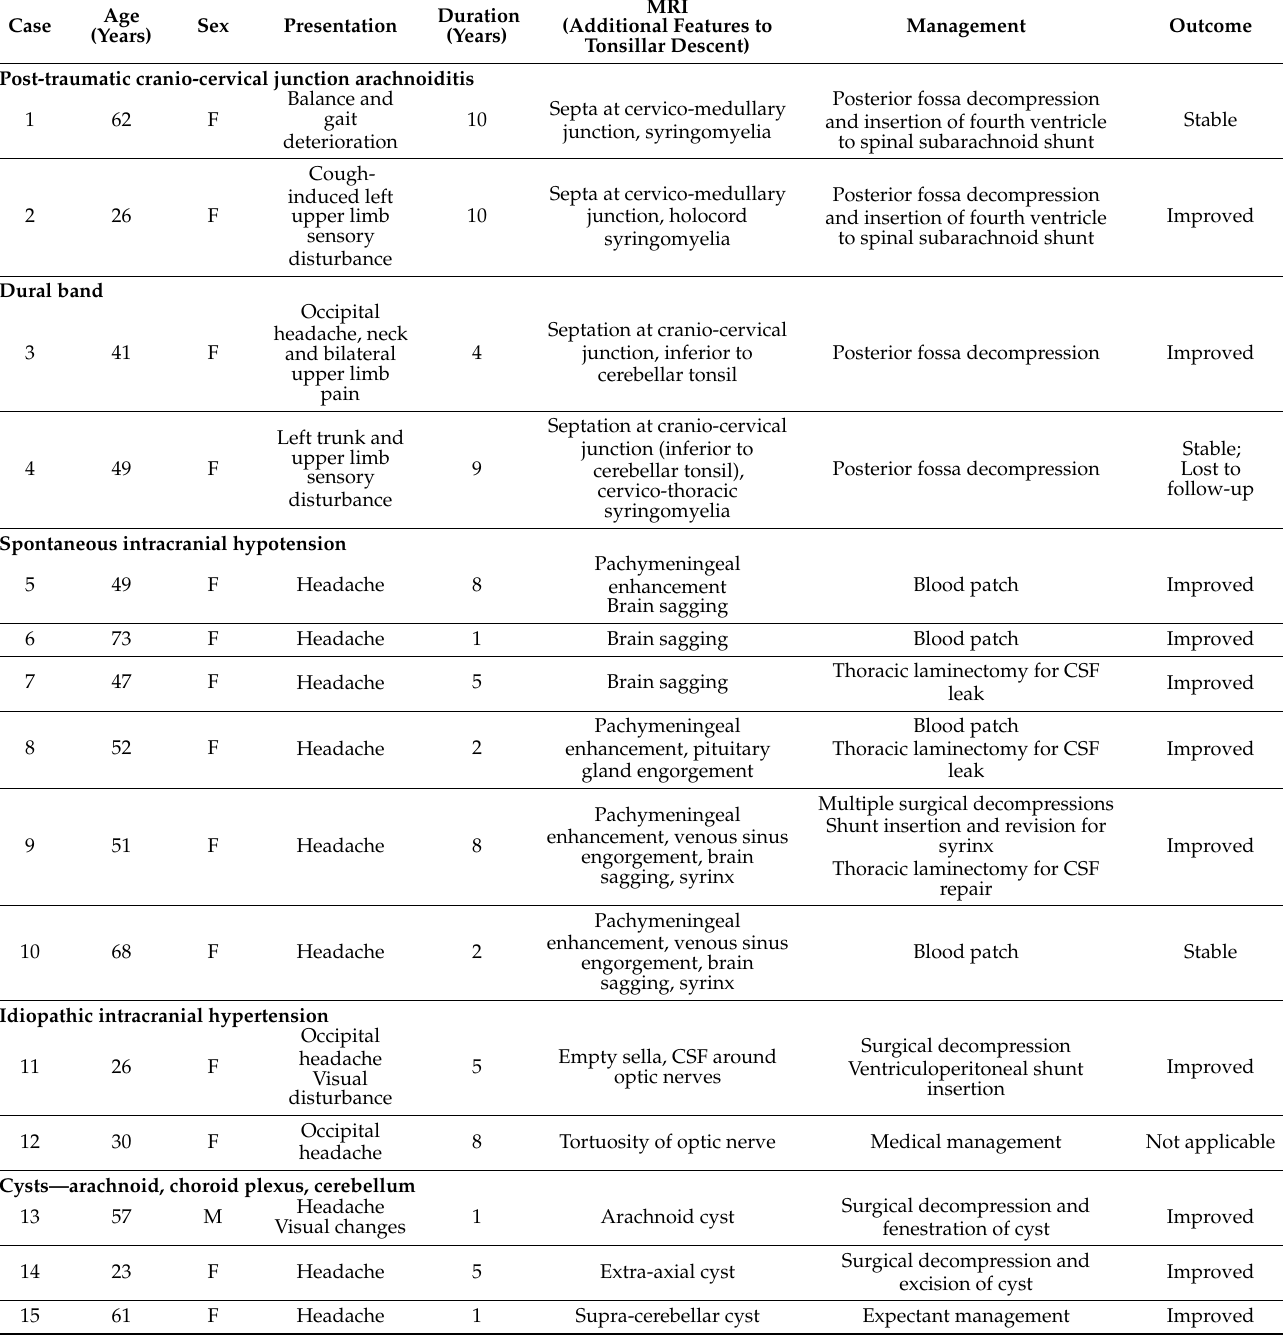
Table 1. Summary of five conditions that mimic Chiari I